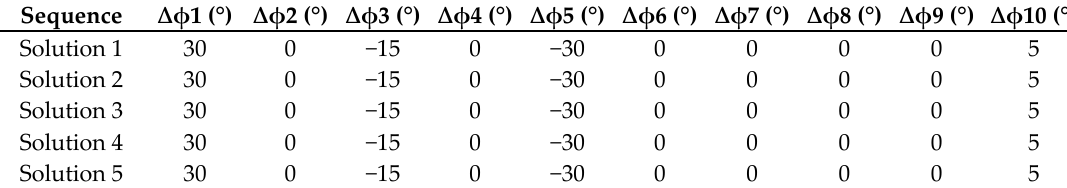
Table 6. Optimal solutions in a head-on situation.